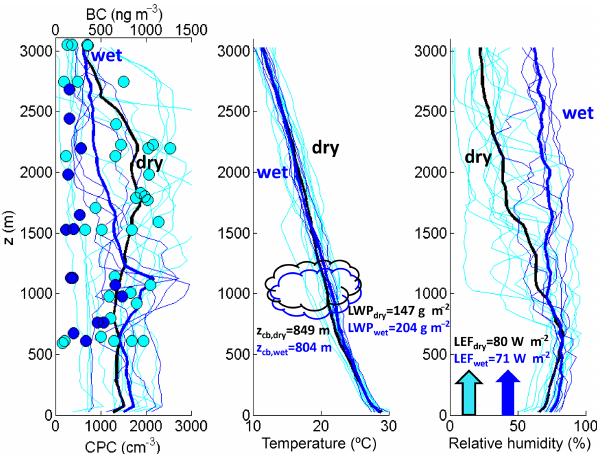
Figure 4. Aerosol, temperature, and relative humidity vertical pro- files from the MAC4 aircraft for individual wet (dark blue) and dry (cyan) flights, as indicated by Table 2. The thin lines indicate indi- vidual profiles, and the thick lines indicate the ensemble mean. For visual clarity, the ensemble mean of the dry cases is shown in black, while the individual profiles are in cyan. Black carbon retrievals are shown as discrete circles as they required a period of level flight to obtain an accurate reading. There were 12 dry and 5 wet flights with this aircraft; a description of the flight conditions and times may be found in Table 2. Note that the strong temperature inversion on dry days is most evident in the individual profiles rather than the means, as the latter tends to average out the inversion due to dif- fering boundary layer heights. The average values of LWP, z cb , and LEF are measured at MCOH from the MWR, MPL, and gust probe instrumentation, respectively, and are also shown in Table